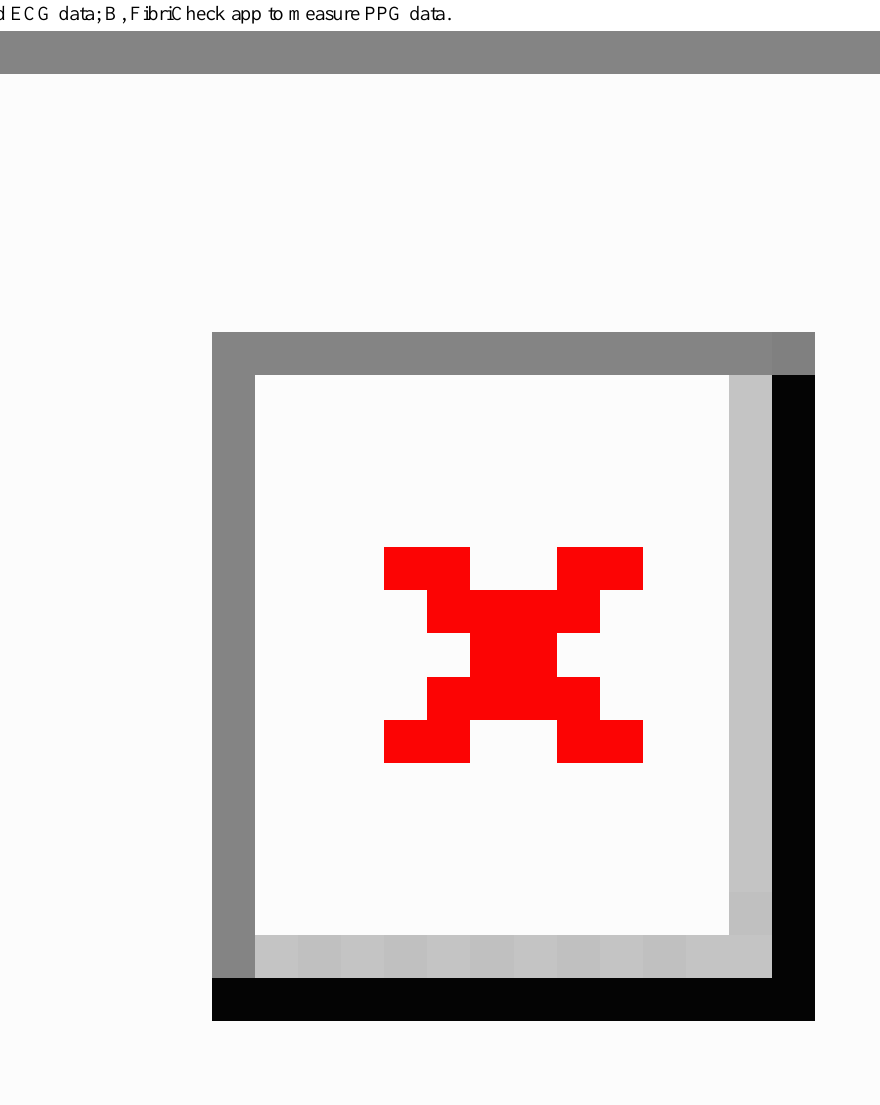
Figure 6. Measurement setup for simultaneous photoplethysmography (PPG) and electrocardiography (ECG) recording. A wearable ECG sensor to measure 1-lead ECG data; B, FibriCheck app to measure PPG